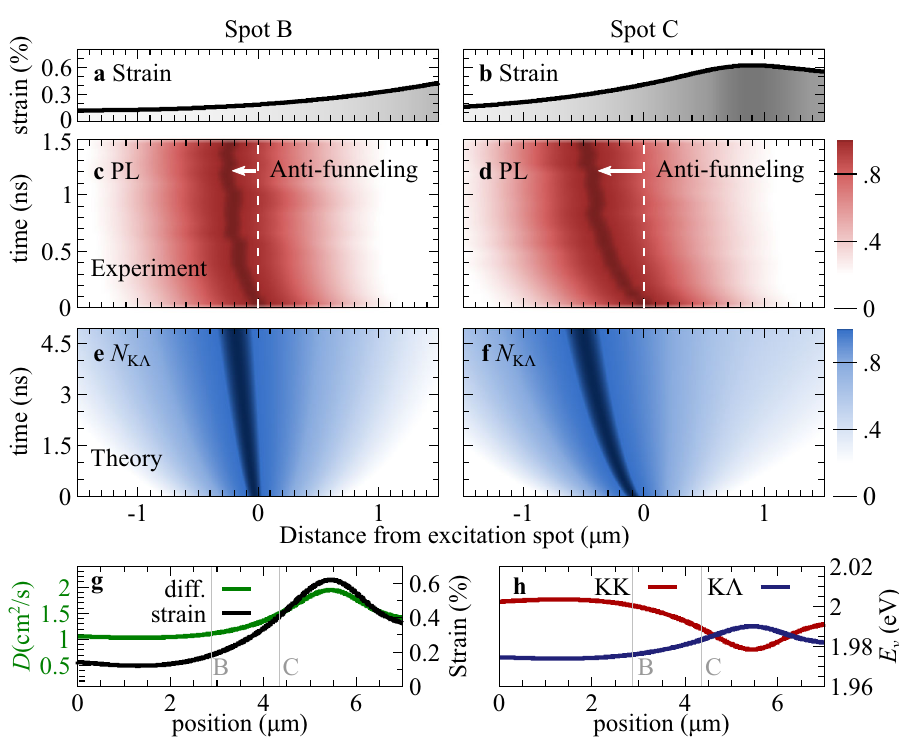
Fig. 3 Exciton anti-funneling: experiment-theory comparison. a,b Spatial strain pro fi les at the spots B and C (illustrated in Fig. 2 b,c ). c,d Experiment: Spatiotemporal evolution of the PL signal imaged with the streak camera after an optical excitation at the spots B and C. e,f Theory: Temporally and spatially resolved dynamics of momentum-dark K Λ excitons obtained by solving the drift-diffusion dynamics [cf. Eq. (1)] assuming the same conditions as in the experiment. g Spatially dependent strain pro fi le (black line, extracted from the experiment, cf. Fig. 2 e ) and theoretically predicted diffusion coef fi cient (green line) and h energy of bright KK and dark K Λ excitons. The position of the investigated spots B and C are denoted by thin vertical